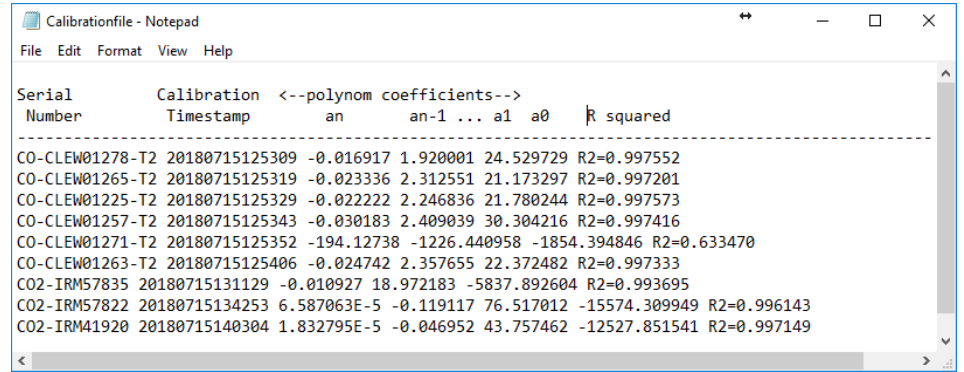
Figure 9. Polynomial coefficients stored in the SD card at the sensor node. One line for each gas sensor with its absolute identifier (serial number).